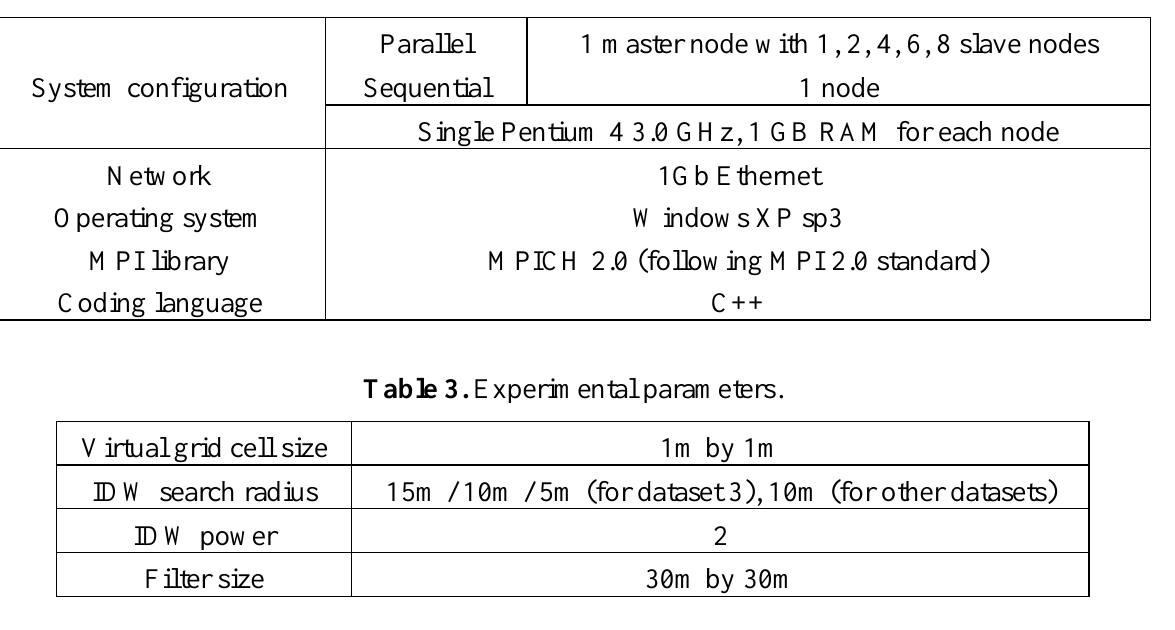
Table 2. PC cluster specifications.